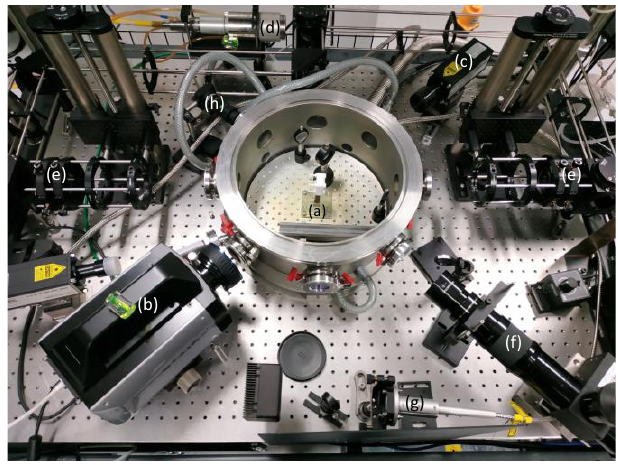
Fig. 5. Picture of the experimental configuration. (a) Sample holder in the center of the opened experimental chamber ; (b) High speed MWIR thermal camera ; (c) Pyrometer ; (d) High power Laser collimator for transient heating ; (e) Optical systems for annular beam generation ; (f) long